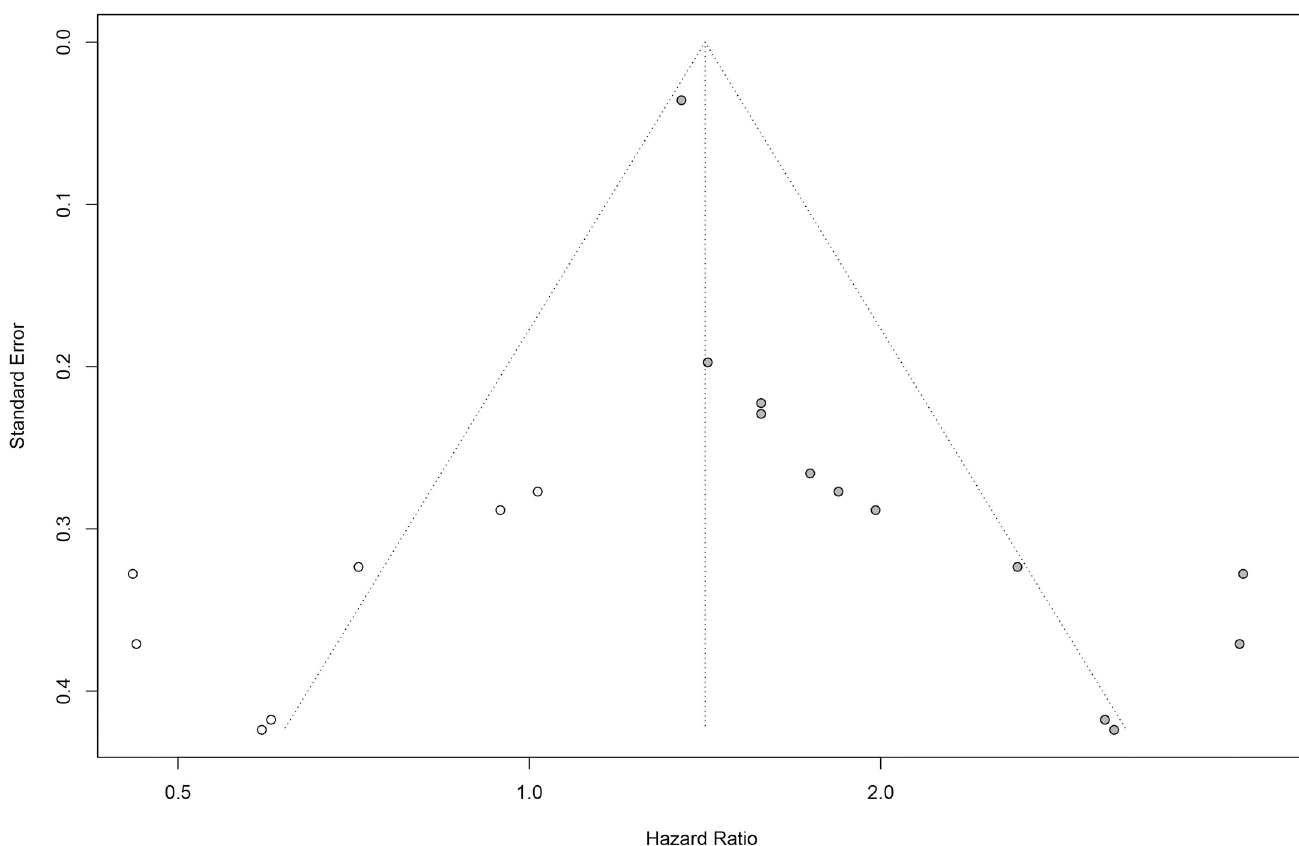
Fig 6. Funnel plot after a trim and fill